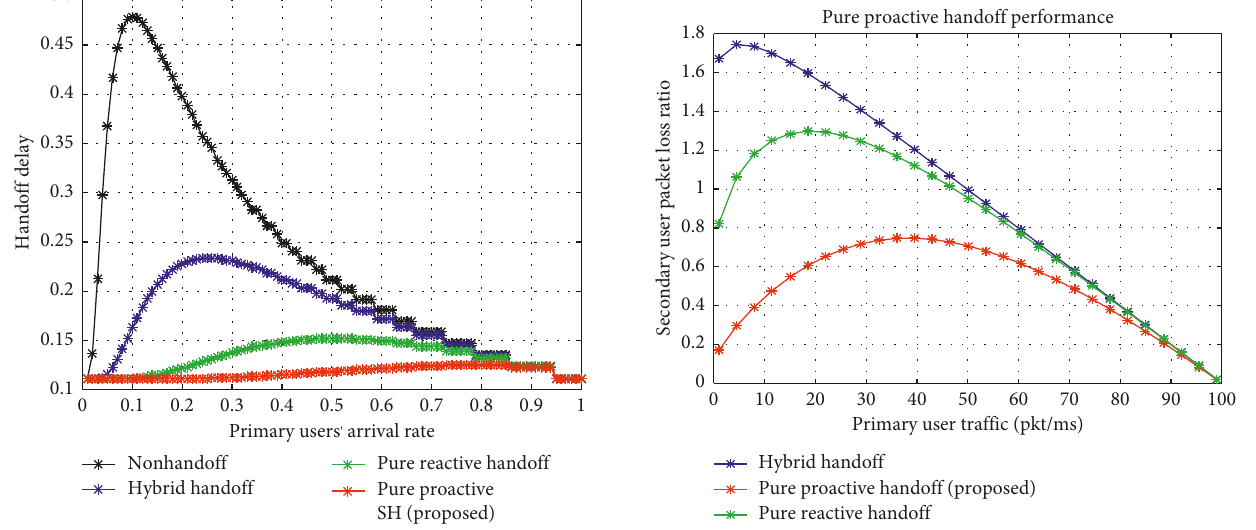
Figure 8: Performance of different spectrum handoff techniques in terms of delay (latency).